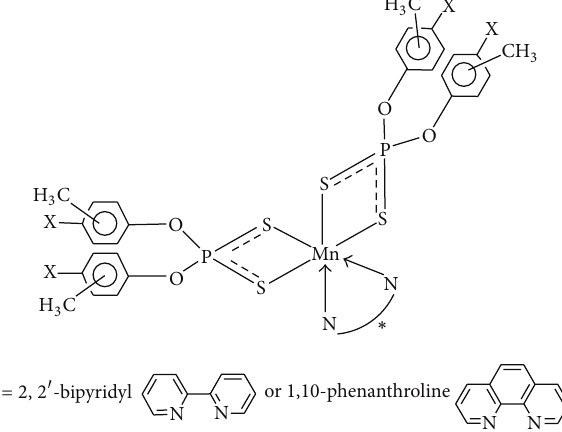
Figure 7: Proposed octahedral structure of manganese(II) com- plexes with 1,10-phenanthroline ( 5 – 8 ) and 2,2 󸀠 -bipyridyl ( 9 – 12 ); X = H, CH 3 , or